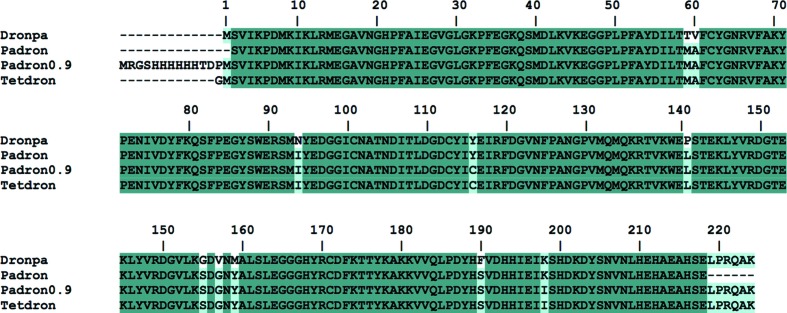
Amino-acid sequence alignment of Dronpa, Padron, Padron0.9 and Tetdron.